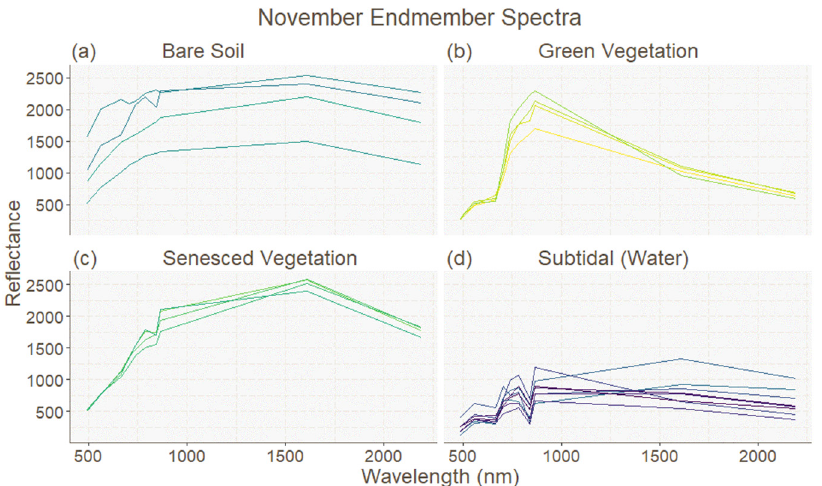
Figure 2. Spectral library for November 2017. Axes are ( x -axis) wavelength in nm and ( y -axis) reflectance values. Spectral signatures for ( a ) bare soil, ( b ) green vegetation, ( c ) non-photosynthetic vegetation (senesced), and ( d ) subtidal cover classes. Colors used for visual differentiation of the different endmembers.